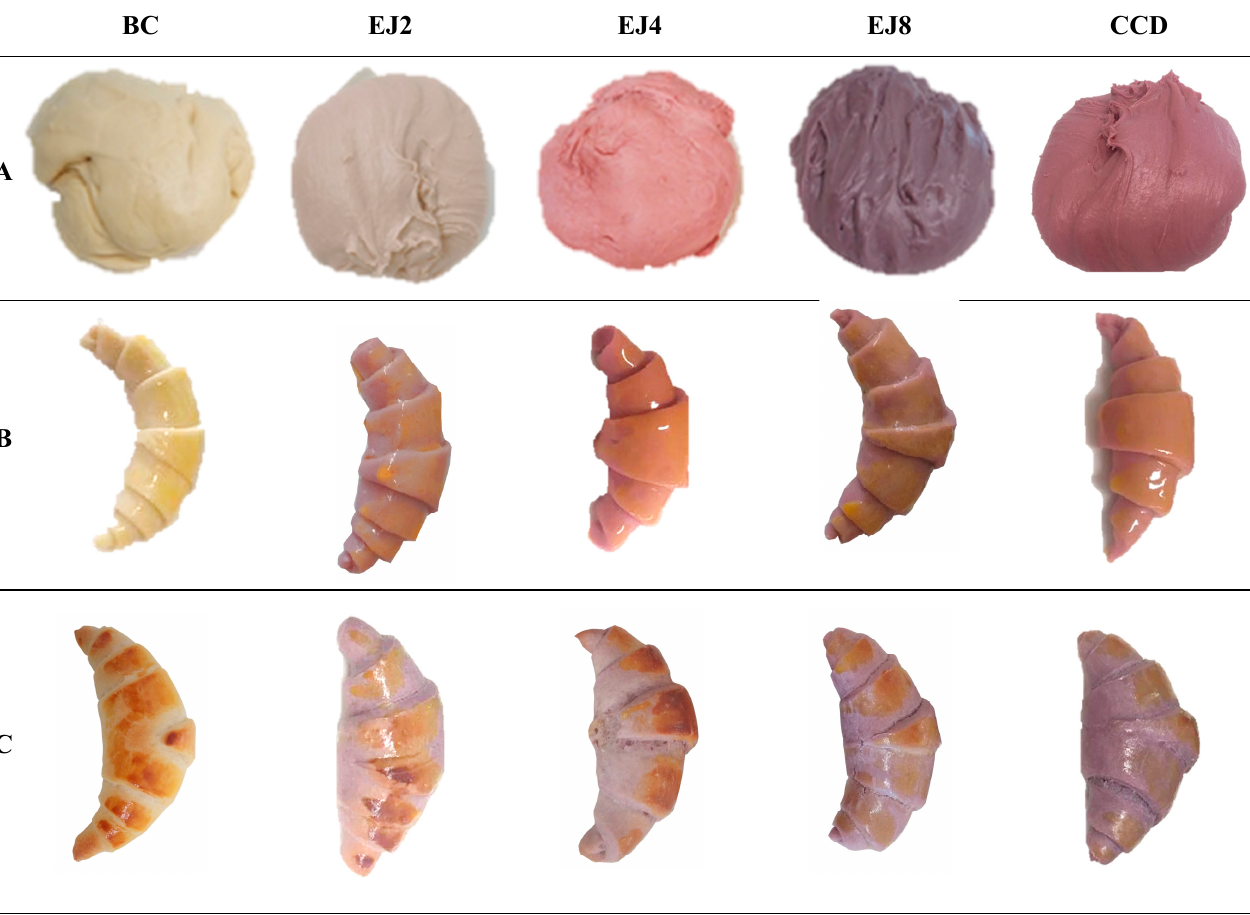
Figure 2. Appearance of different croissant formulations. ( A ) after second fermentation of batter; ( B ) before baking; ( C ) after baking. BC: croissant with no colorants adding; EJ2: croissant with 2% of elderberry juice (EJ2); EJ4: croissant with 4% of elderberry juice; EJ8: croissant with 8% of elderberry juice; CCD: croissant with 4% of the commercial carrot dye.